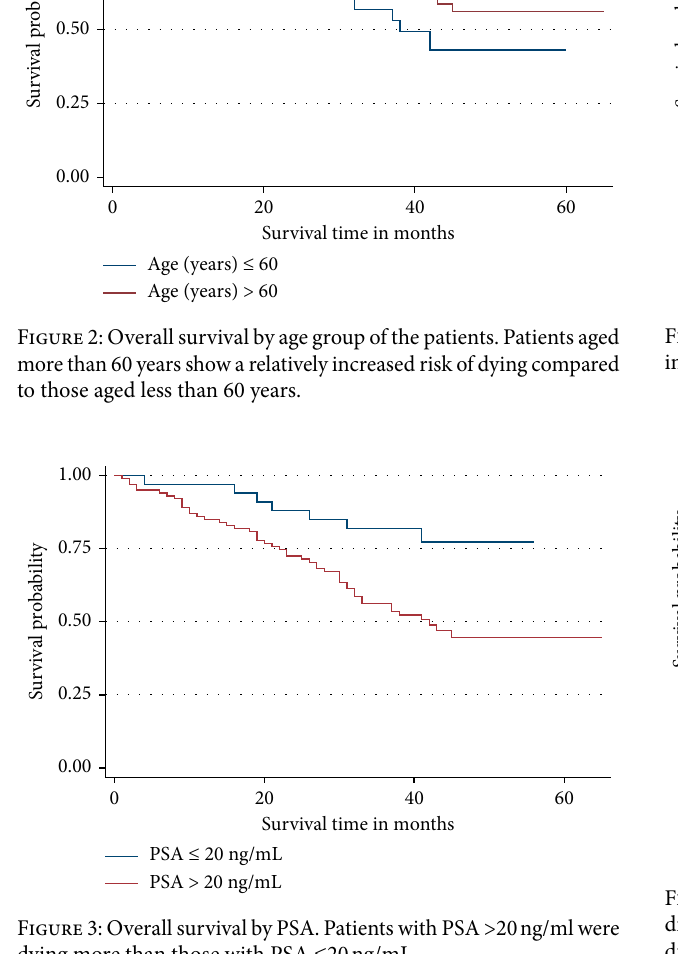
Figure 3: Overall survival by PSA. Patients with PSA >20 ng/ml were dying more than those with PSA ≤20 ng/mL.